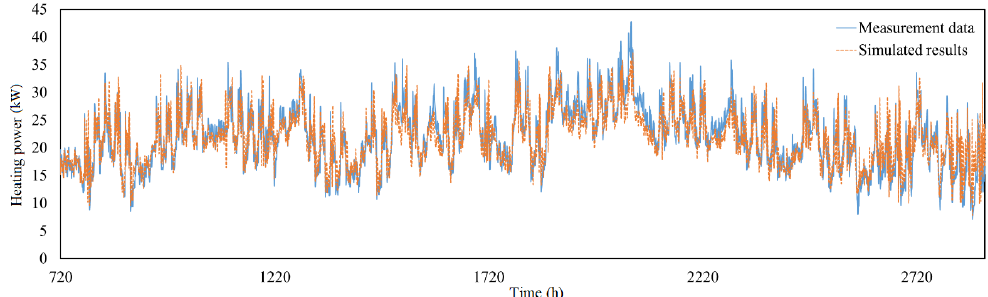
Figure 4. An example of a 3-month comparison between measured and simulated heat consumption after calibrating the thermal zone model.